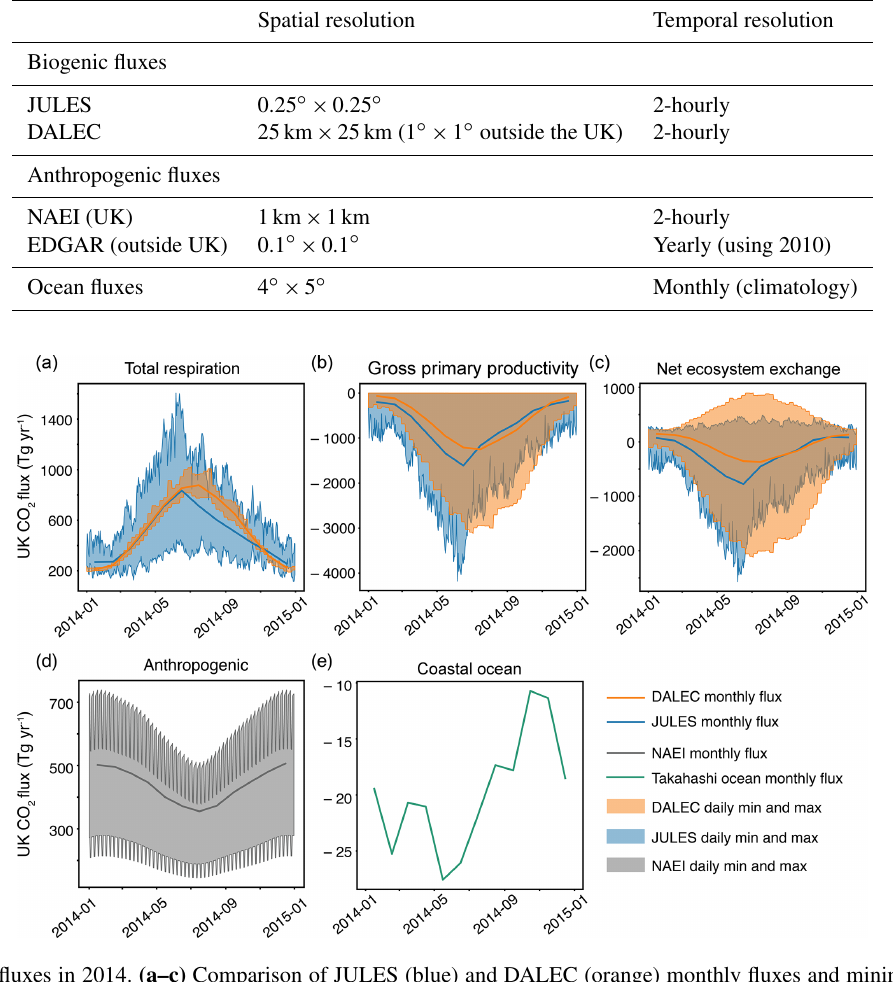
Table 2. Specifications for different prior and fixed fluxes.